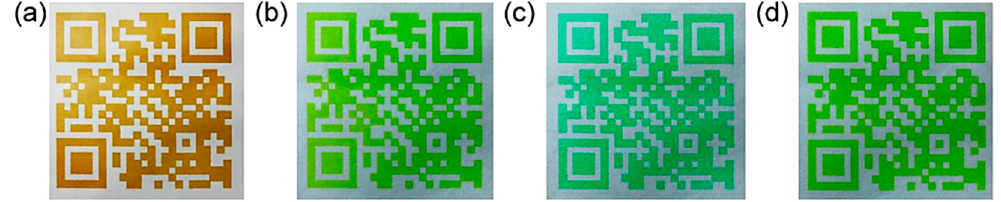
Figure 10. QR code printed with C-dot-based ink and seen under ( a ) natural light and ( b – d ) 365 nm UV light; ( c ) is coated with dilute NaOH solution, while ( d ) is coated with dilute acetic acid. Reproduced with permission from reference [59], Carbon; published by Elsevier Ltd., 2019.